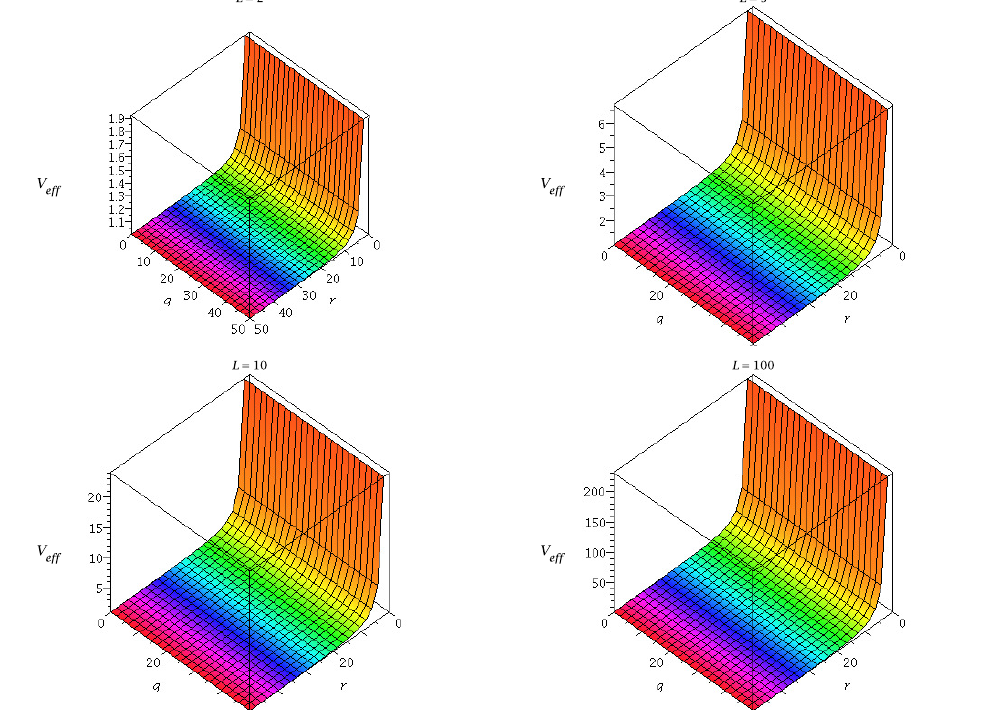
Figure 4. The figure shows the variation of V ef f with r for ABG